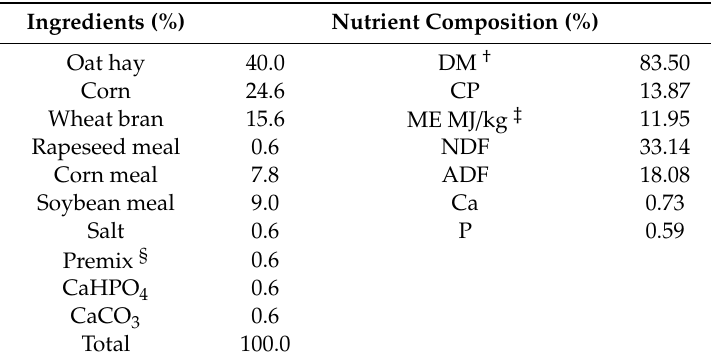
Table 1. Ingredients and nutrient composition of the